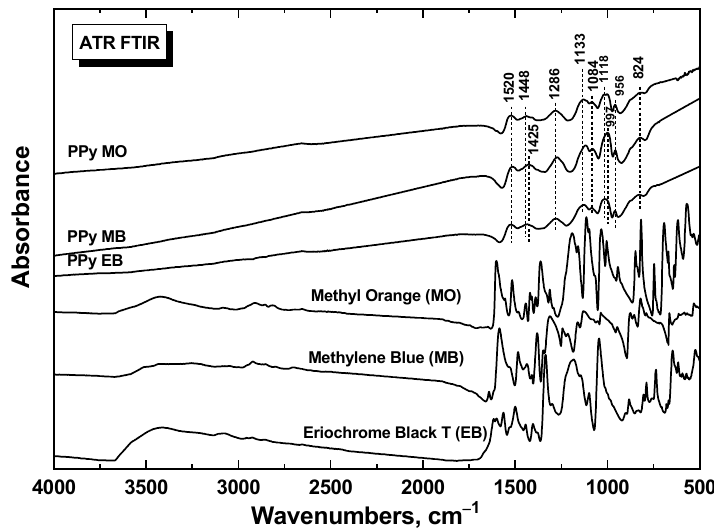
Figure 2. FTIR spectra of prepared samples and initial dyes.